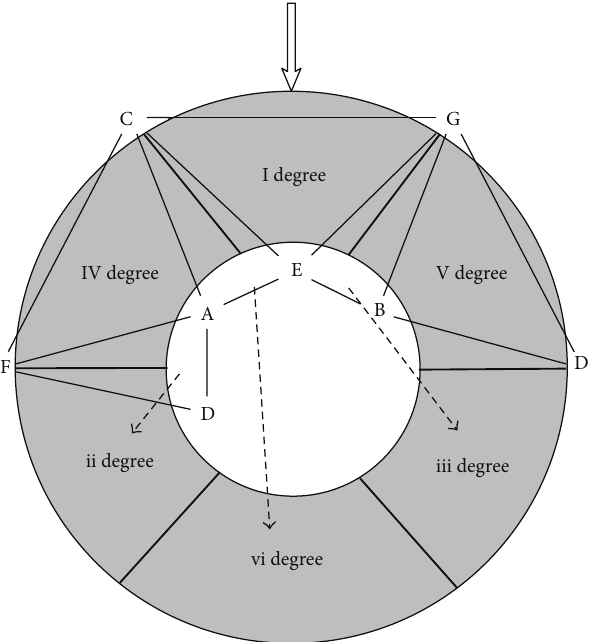
Figure 6: The “stretched” tonnetz with the parallel harmonies overturned in the lower part of the circular ring. The white arrow indicates the position of the tonic, which is in most cases the beginning of a tonal